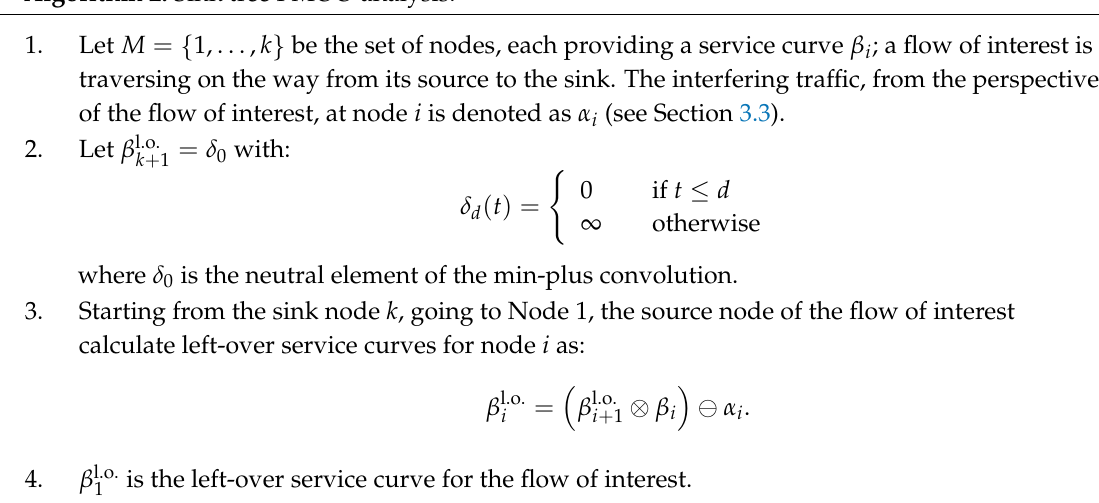
Algorithm 2: Sink tree PMOO